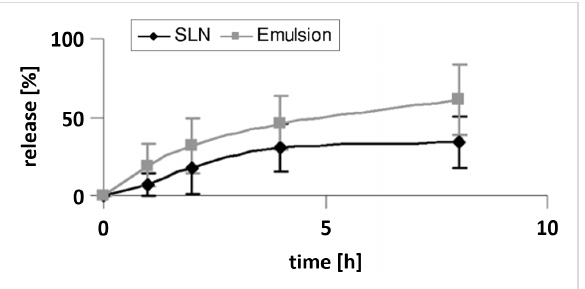
Figure 11: In vitro release of the sunscreen oxybenzone from a nanoemulsion (grey) and from a SLN suspension (black) measured in Franz diffusion cells, after